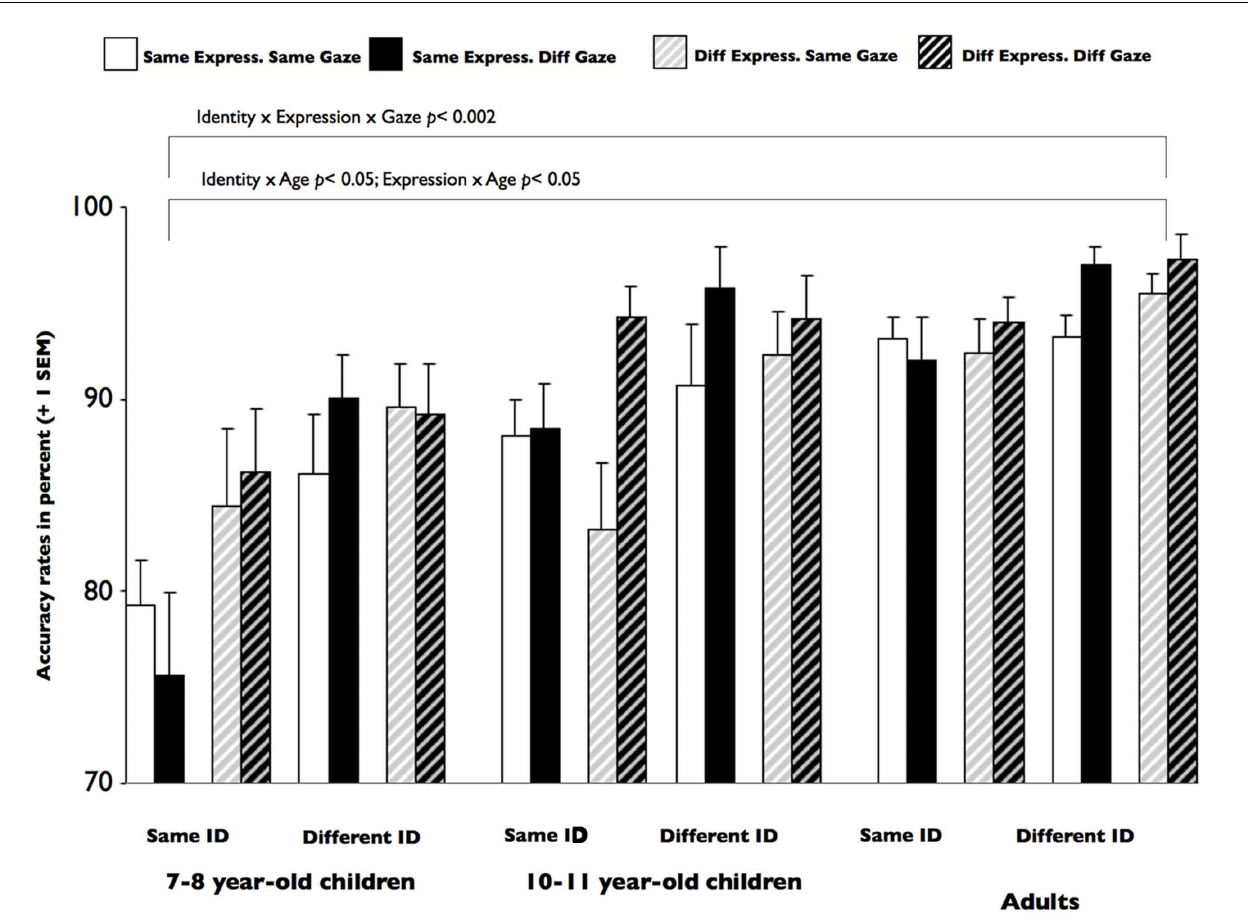
FIGURE 7 | Experiment 2: three-way interaction for identity × expression × gaze for the reaction accuracy rates for all three age groups. Additional parentheses highlight significant F -tests (interactions and main effects, not t -tests). Diff, different; Express, expression; ID,